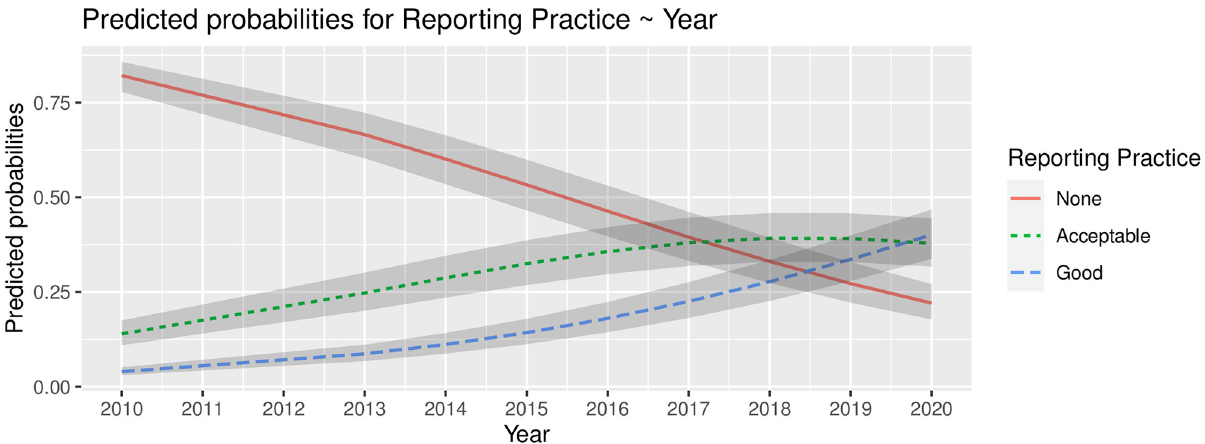
Fig 5. Predicted probabilities from an ordinal regression model with Reporting Practice as a function of year . The shaded ribbons correspond to the 95% confidence interval of the predicted values.